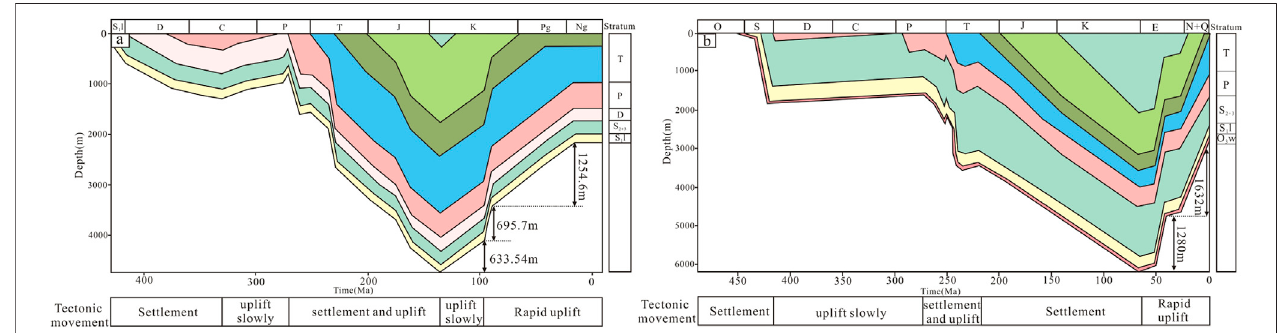
FIGURE 2 | Burial history of Longmaxi Formation shale in southern Sichuan. (A) Burial history in Changning area and (B) burial history in Luzhou